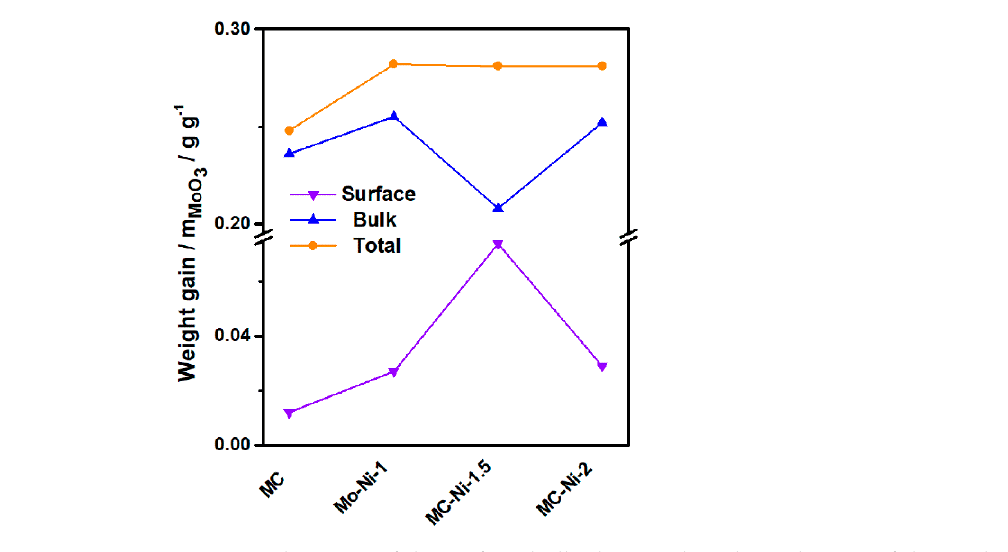
Figure 8. The ratios of the surface, bulk phase and total weight gain of the catalysts to the total weight of MoO 3 obtained by the complete oxidation of the catalysts, calculated from the TG analysis results.